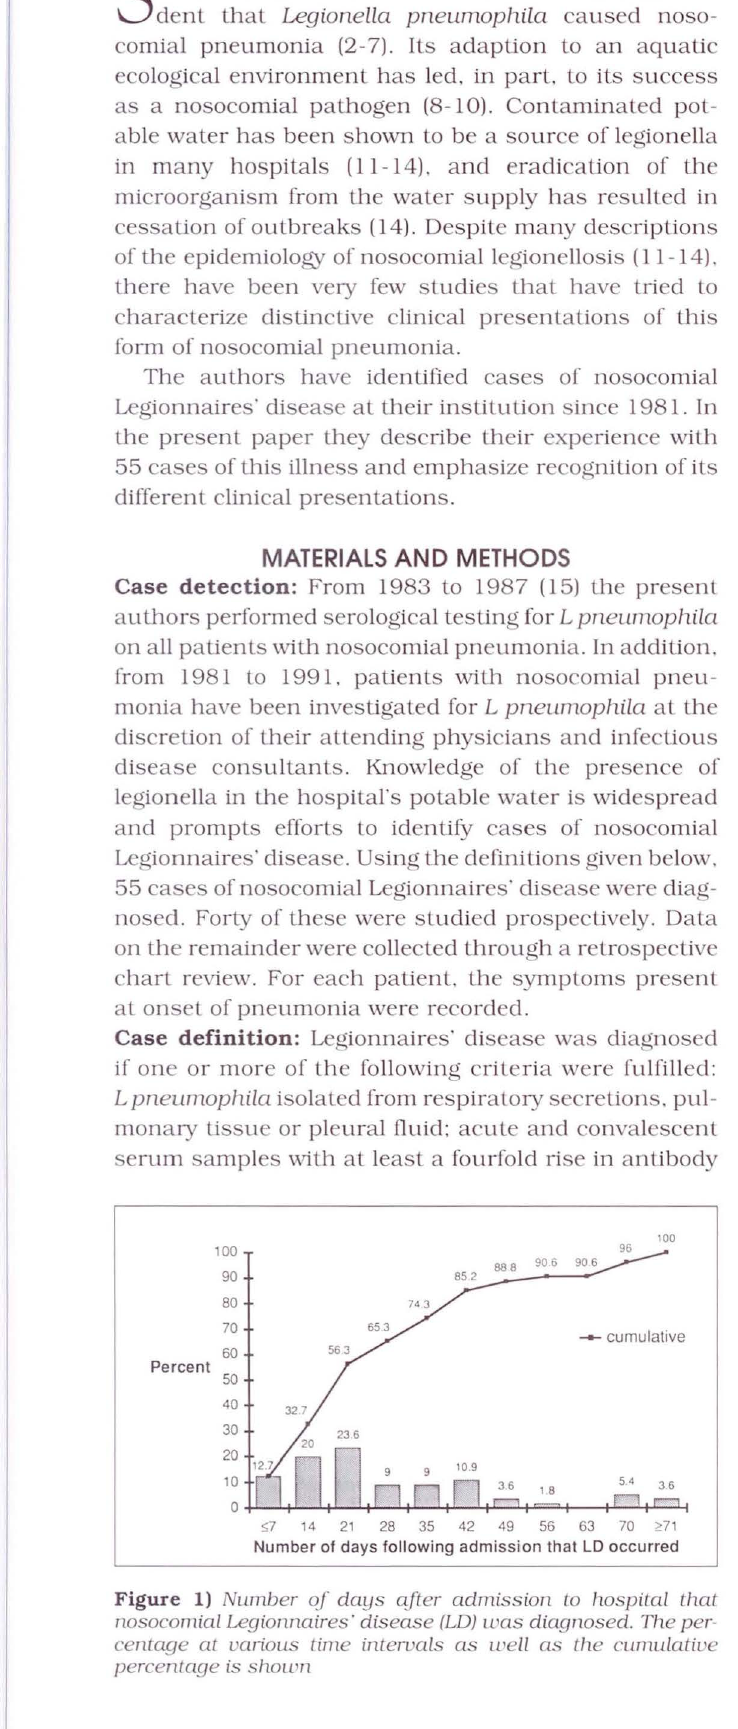
Symptoms and signs in 55 patients with